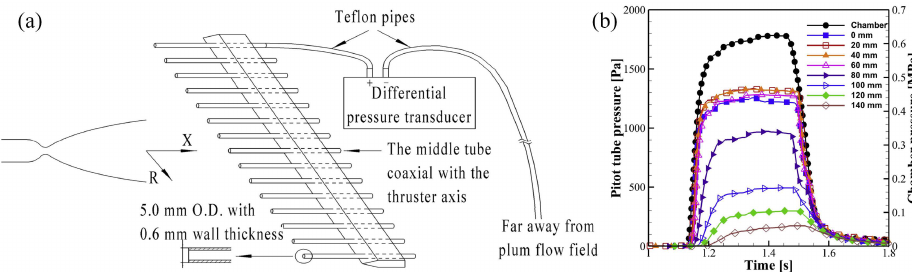
Figure 4. ( a ) Schematic of Pitot tube array and ( b ) its typical measurement results of a plume flow exhausted by a bipropellant thruster (60 N)